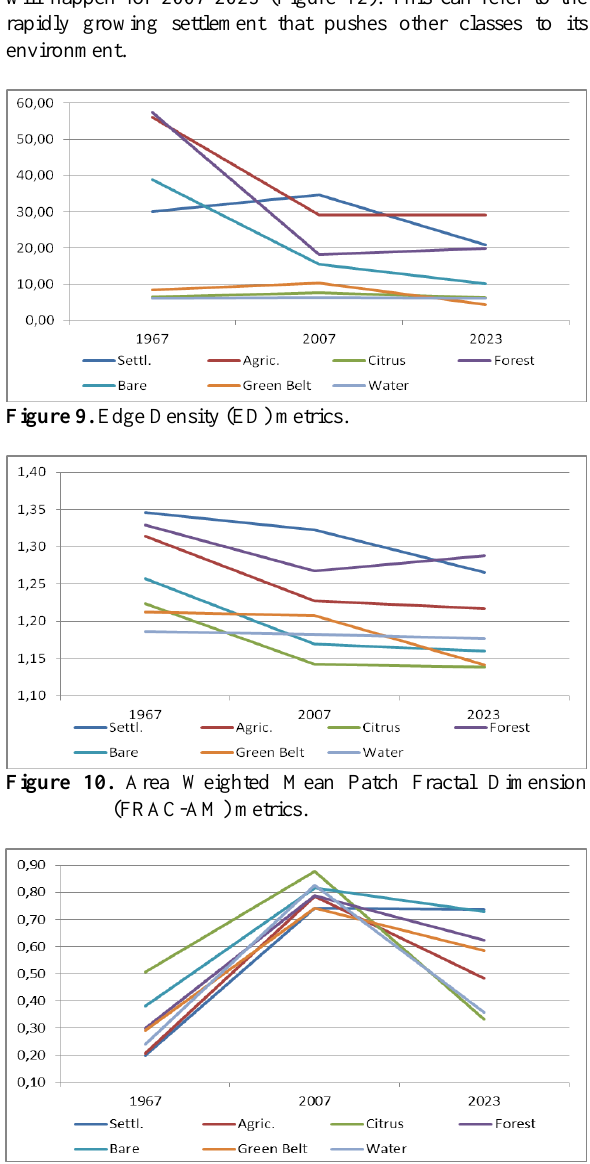
Figure 11. Contagion Index (CONTAG) metrics.